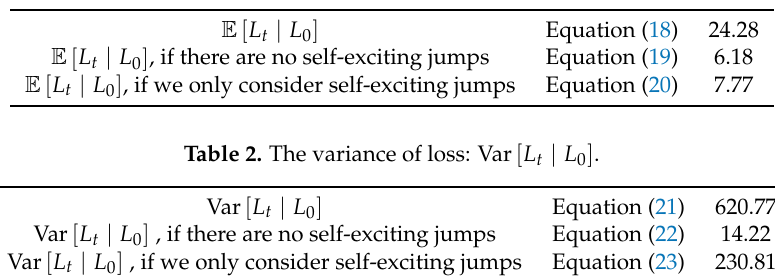
Table 1. The expectation of loss: E [ L t | L 0 ] .